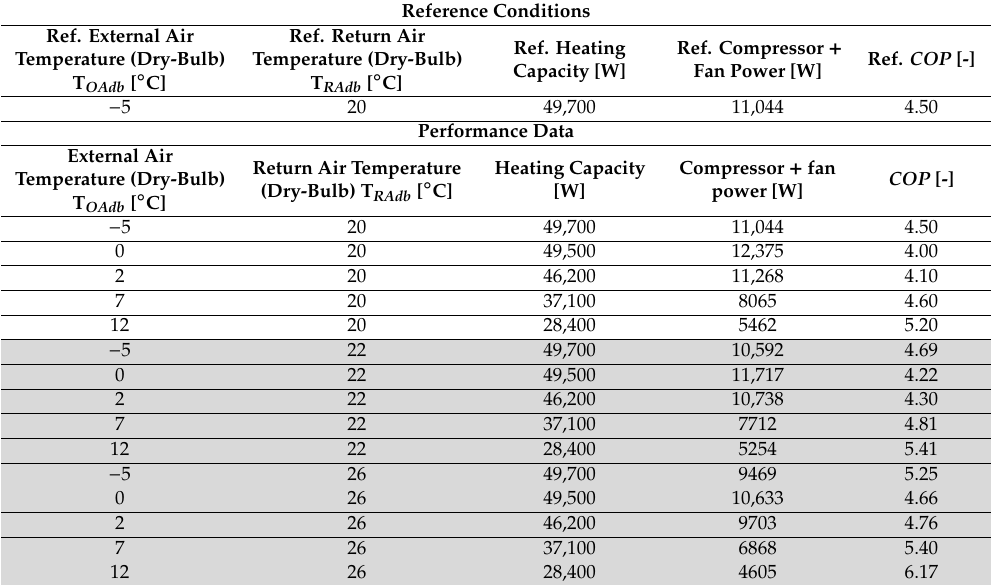
Table 6. Datasheet values in heating mode for present study analyses (manufacturer data in gray).